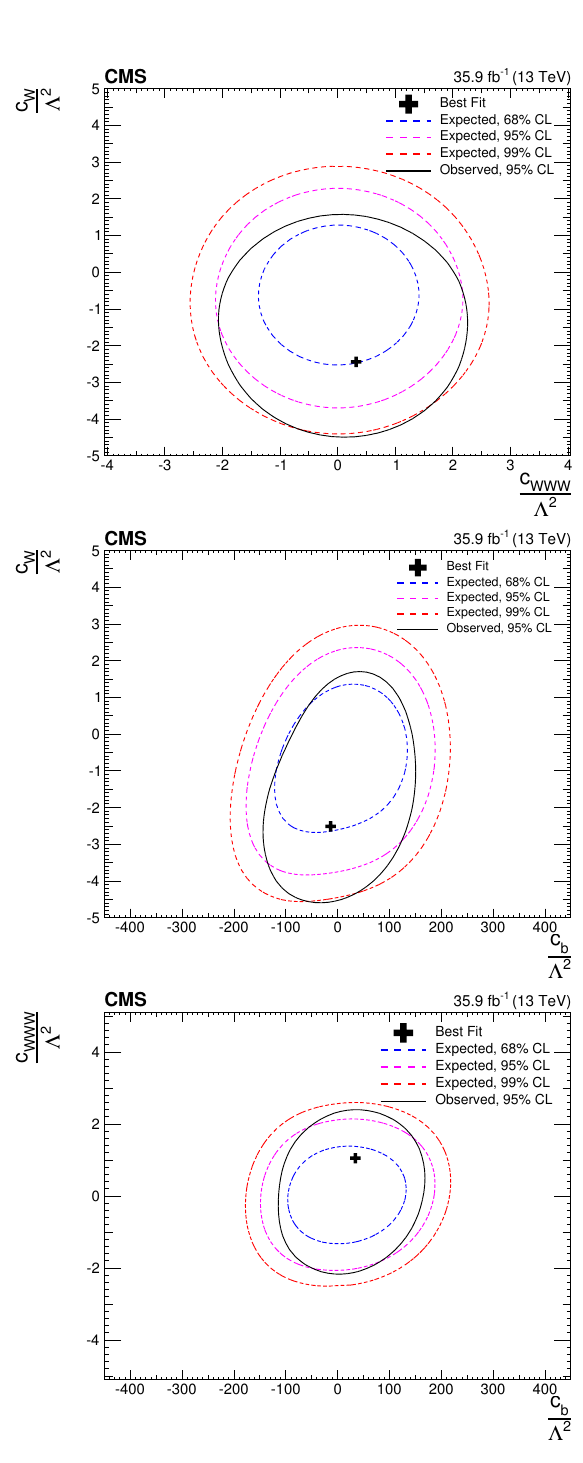
Figure 16 . Two-dimensional con(cid:12)dence regions for each of the possible combinations of the con- sidered aTGC parameters. The contours of the expected con(cid:12)dence regions for 68% and 95% con(cid:12)dence level are presented in each case. The parameters considered in each plot are c W { c WWW (top), c W { c b (middle) and c WWW { c b (bottom).